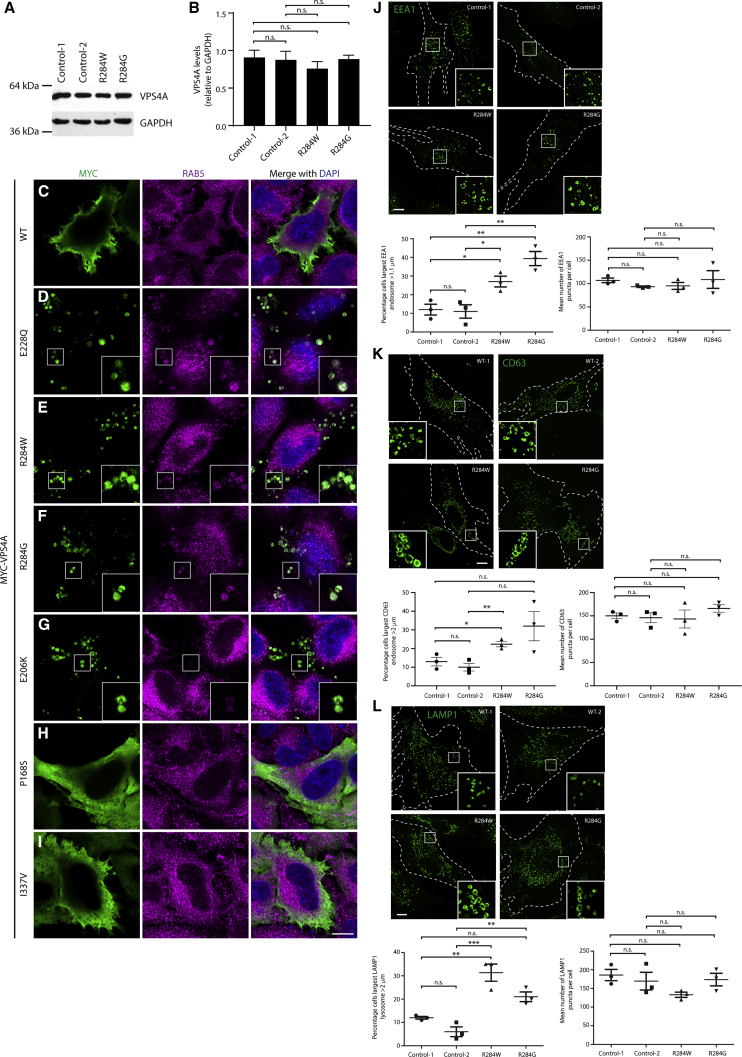
VPS4A Disease-Associated Variants Have a Dominant-Negative Effect on Endosomal Morphology(A) Representative VPS4A immunoblots of fibroblast cell lysates from a proband (proband 1) with the p.Arg284Trp sequence change and her parents (control 1 and control 2), and from a proband (proband 2) with the p.Arg284Gly sequence change.(B) Immunoblot band intensities from three such experiments were quantified, normalized to GAPDH loading control values, and plotted in the corresponding graph.(C–I) HeLa cells were transfected with constructs expressing wild-type myc-VPS4A, myc-VPS4A containing the rationally designed ATPase-defective p.Glu228Gln mutant, or myc-VPS4A harboring the sequence changes identified in probands. Cells were fixed, labeled with anti-Myc and anti-RAB5 antibodies, and visualized with confocal microscopy. The inset panels show higher magnification views of the boxed regions; examples of large vacuolar endosomal structures are shown.(J–L) Cultured fibroblasts from the control subjects and probands indicated were fixed, labeled with EEA1 (early endosomes) (J), CD63 (preferentially labels late endosomes) (K) and LAMP1 (predominantly labels lysosomes) (L), then visualized by widefield immunofluorescence microscopy. The percentage of cells with an endosomal organelle over a nominal cut-off size and the number of labeled organelles per cell was counted in n = 3 biological repeats for each marker (in 100 cells per experimental condition in each repeat), then quantified in the corresponding charts. Bars in all plots show mean ± SEM, p values calculated by one-way ANOVA with Tukey’s post hoc test for repeated-measures. Scale bars = 10 μm.